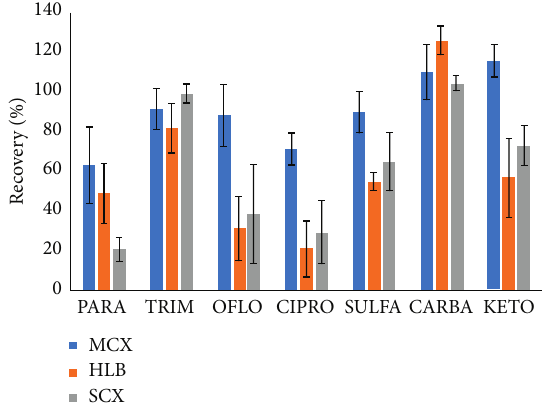
Figure 5: Recoveries of seven pharmaceutical products in surface water on different solid phase extraction materials.